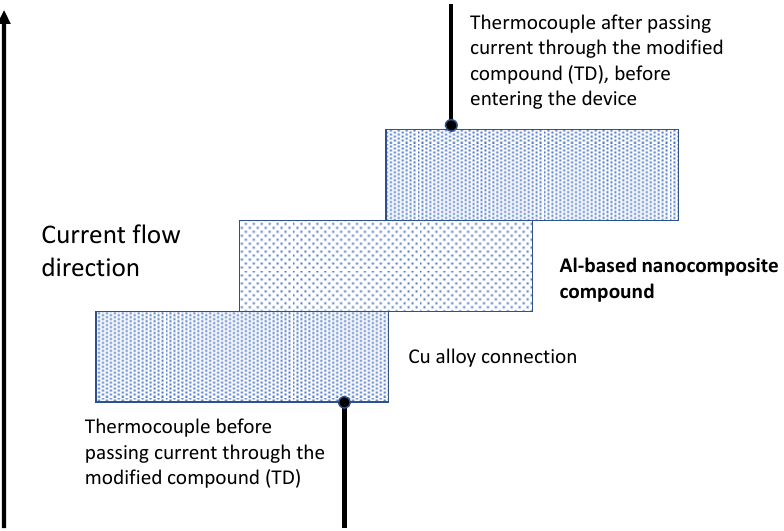
Figure 2. Diagram showing the place of the thermocouples for the home-made test of current at 80% and 100% of the nominal current of the MCCB device.